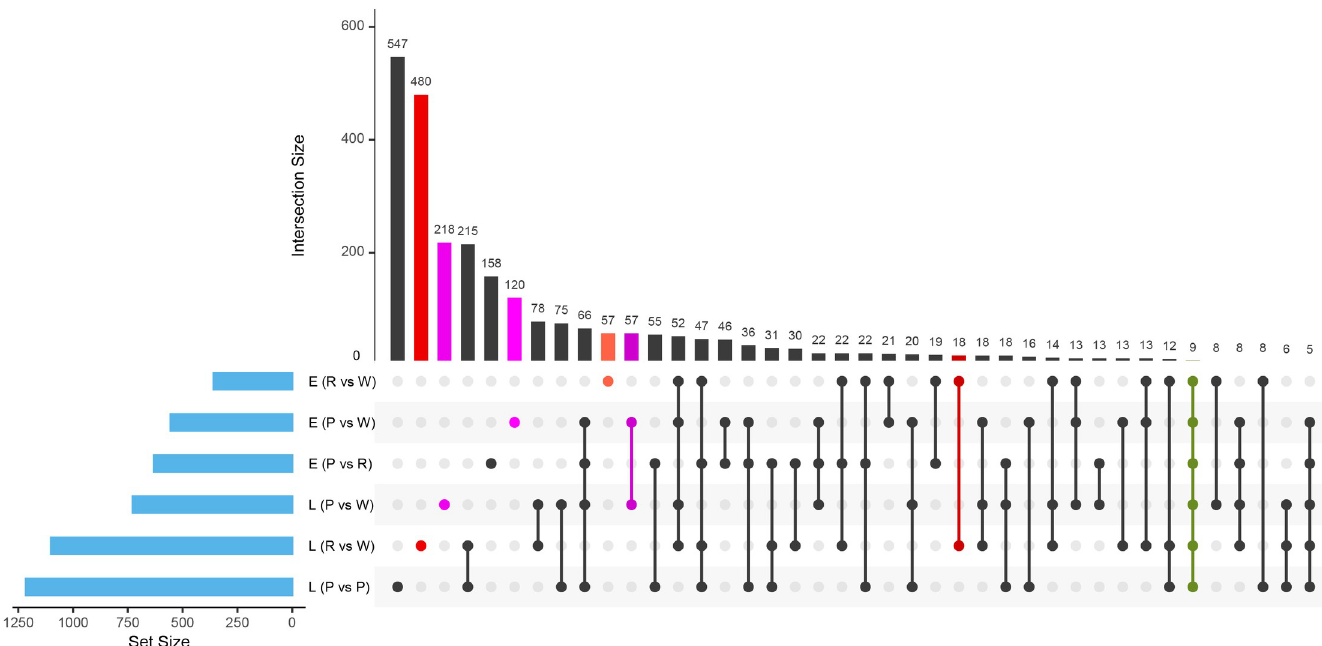
Fig 4. UpSet plot of the differentially expressed genes (DEGs) of RNA-Seq. A quantitative display of the intersection of sets showing the number of differentially expressed genes (FDR threshold value of 5x10 -4 and logFC � 2) between the comparison of developmental stages and spathe colors.